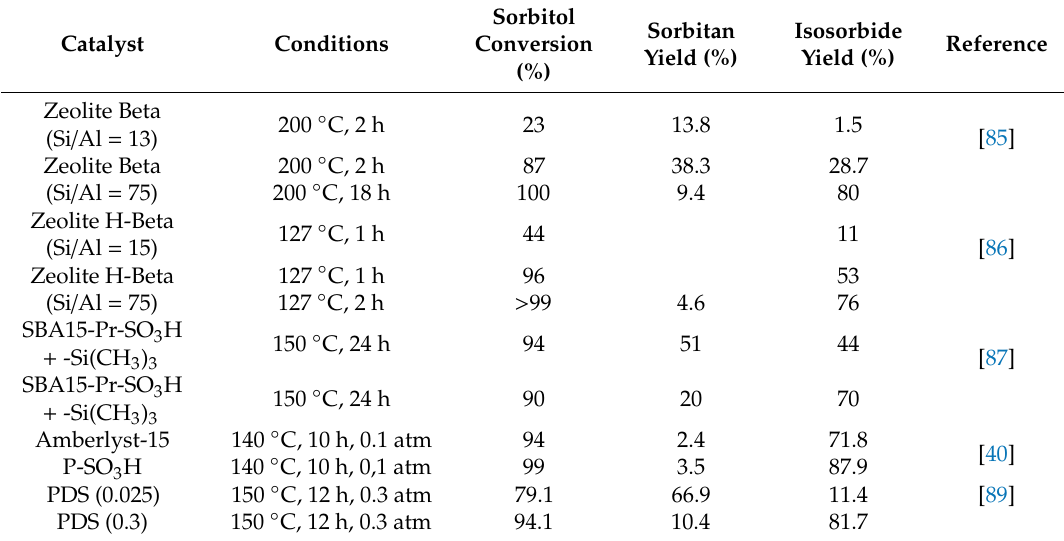
Table 8. Selected examples of sorbitol dehydration with hydrophobized material: direct comparison with the parent (or less hydrophobic)